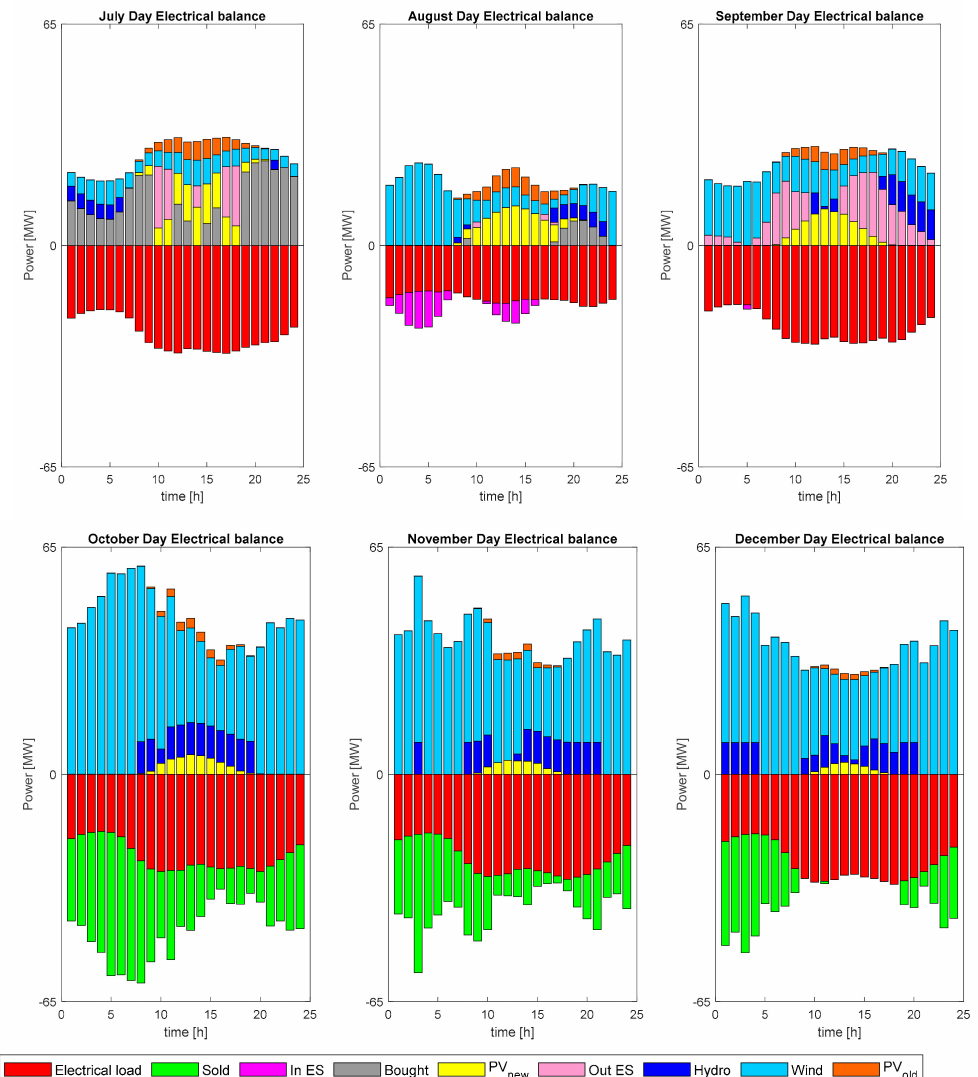
Figure 7. Optimal daily scheduling from July to December typical